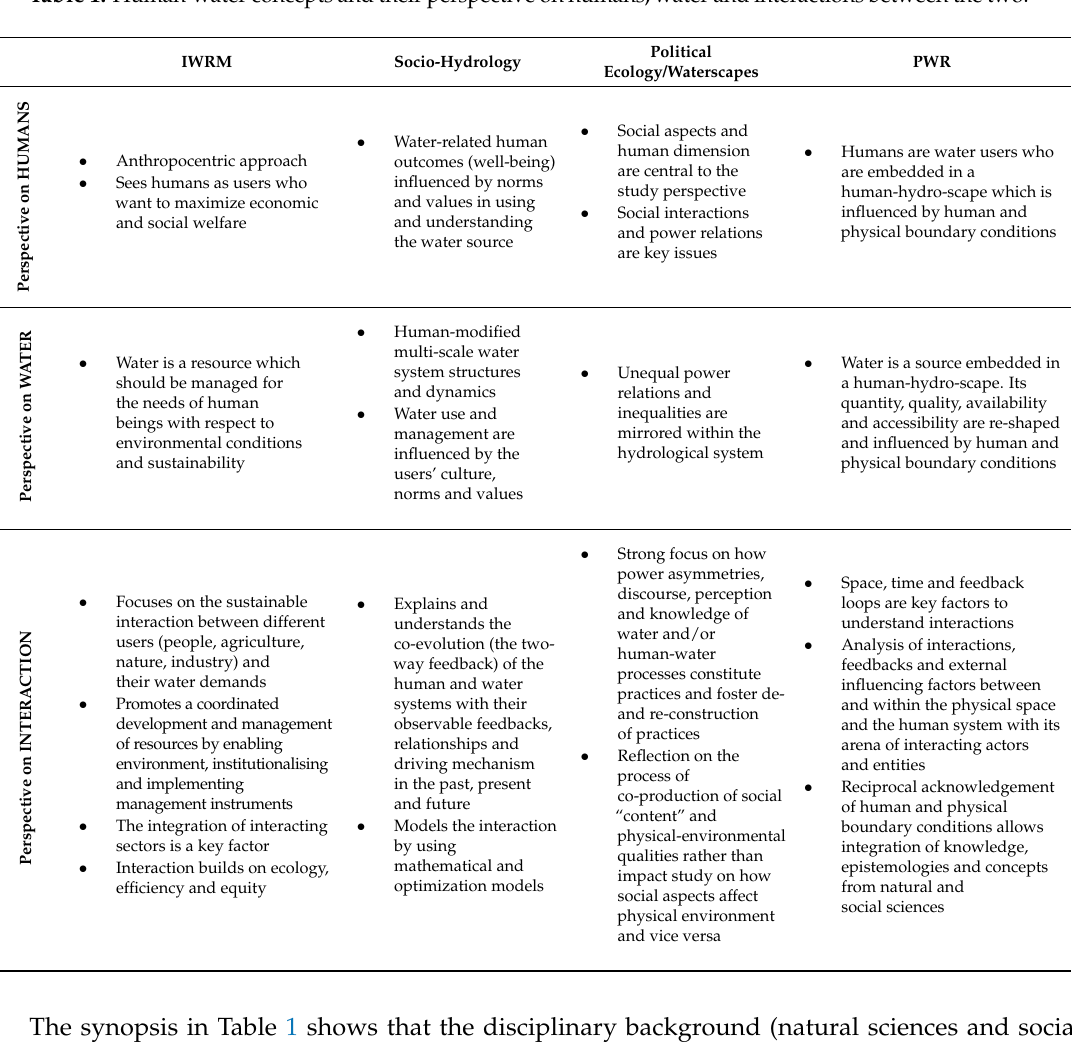
Table 1. Human-water concepts and their perspective on humans, water and interactions between the